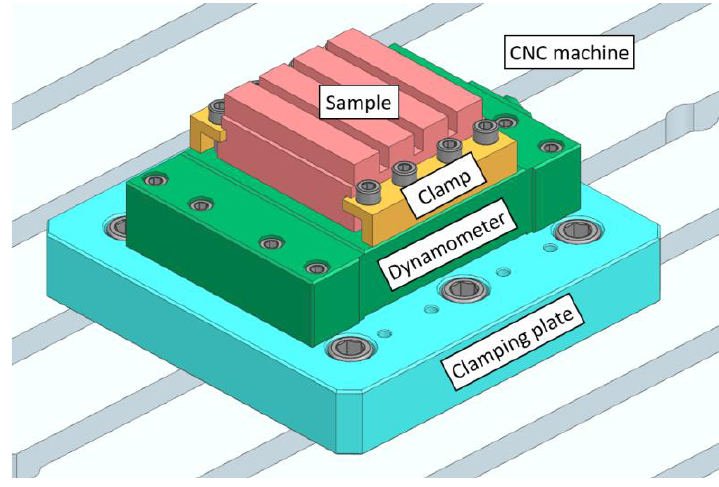
Figure 2. Clamping of the specimen to the dynamometer and CNC machine. Plane milling was chosen for the experiment, in which four surfaces are machined in one series at a time. The width of the machined surface was 14 mm. Length of cut was 74 mm in the main cutting direction. Due to elimination of interfering forces that could in- fluence the value of the scanned data, grooves with a 5 mm thickness were milled into the sides. This enabled easy transition to and out of the cutting process. The cutting conditions changed during milling. The cutting speed (vc), depth of cut (ap) and feed per tooth (fz) varied. The workpiece was clamped on a dynamometer during milling to measure the forces Fx, Fy and Fz acting on the workpiece. After milling the given surfaces, the work- piece was unclipped from the dynamometer and the surface quality parameters, i.e., Ra, Rz and Rt, were measured. Figure 3 shows the orientation of the cutting forces on a Kistler 9129AA dynamometer.